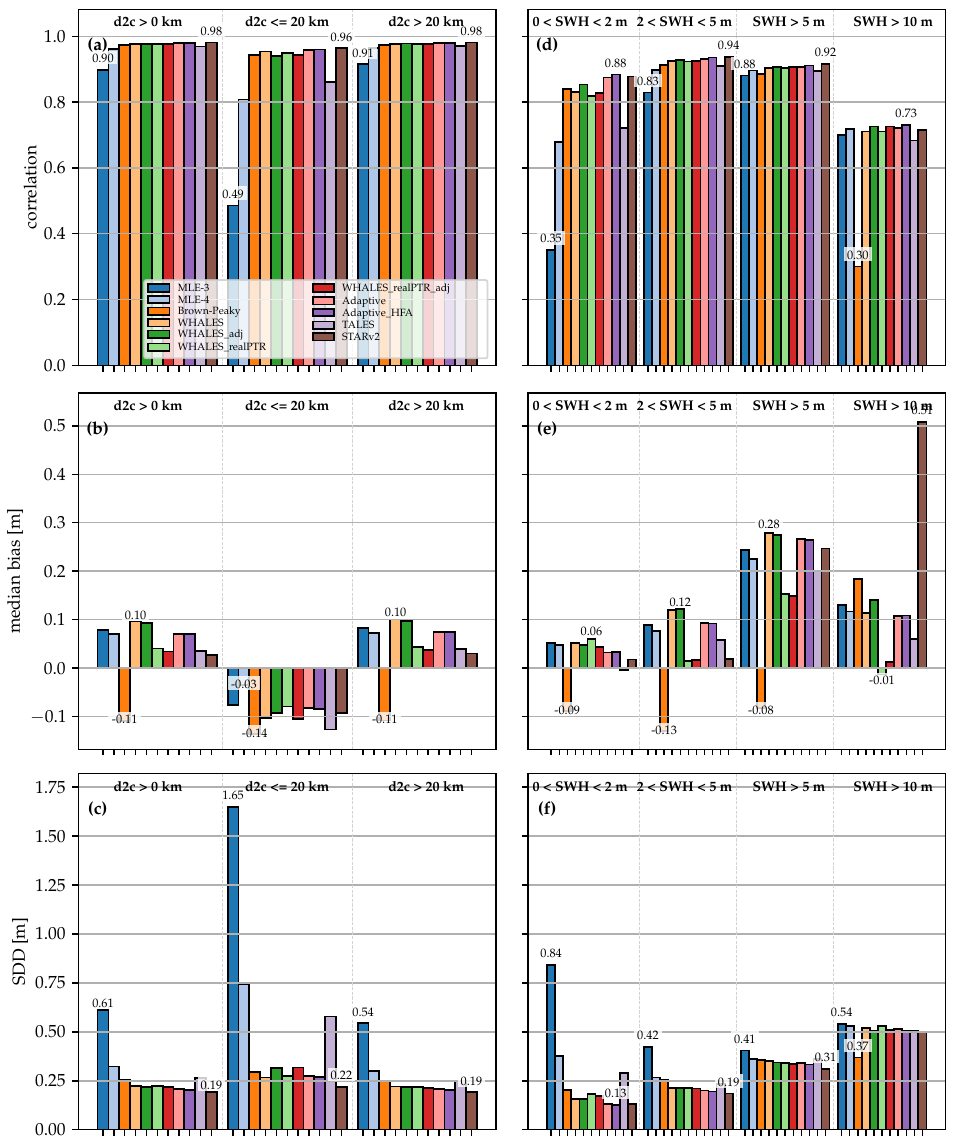
Figure 9. Comparison of the ( a,d ) correlation coefficient, ( b,e ) median bias, ( c,f ) SDD against ERA5-h model of the individual J3 retrackers as a function of dist2coast and of SWH, respectively.